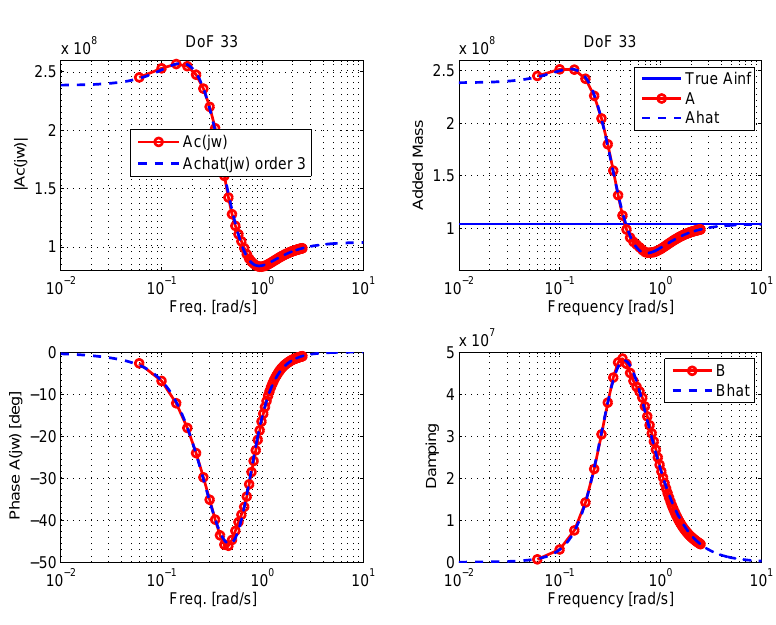
Figure 1: Fitting results for the containership. Left column: Frequency response ˜ A 33 ( jω ) and estimate. Right column: Reconstruction of added mass and damping from the identified fluid memory function ˆ K 33 ( jω ) based on an 3rd order approximation.